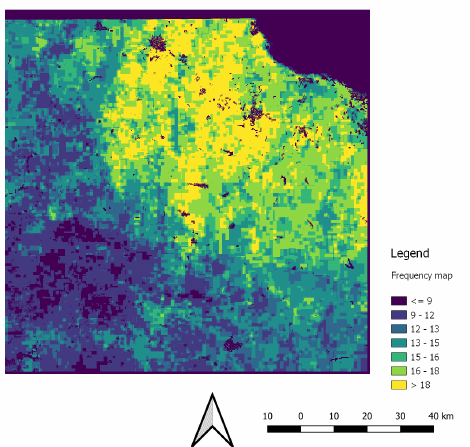
Figure 5. Frequency map of the daily evapotranspiration maps in the Apulia area in March 2019.